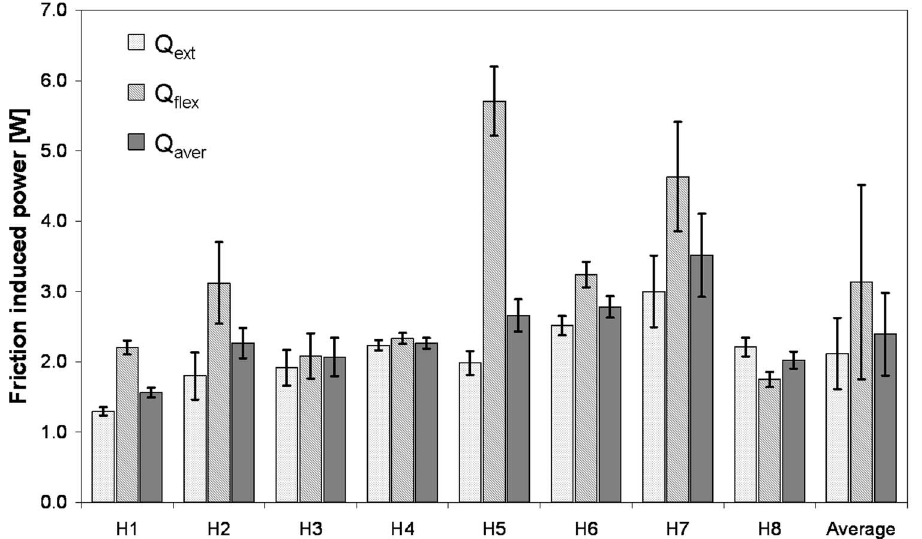
Figure 5. Average friction-induced power Q during flexion and extension phases and whole walking cycle. Q ext =Q during extension phase; Q flex =Q during flexion phase; Q aver =Q during whole step; Individual values of subjects H1 to H8 and averages (right columns).